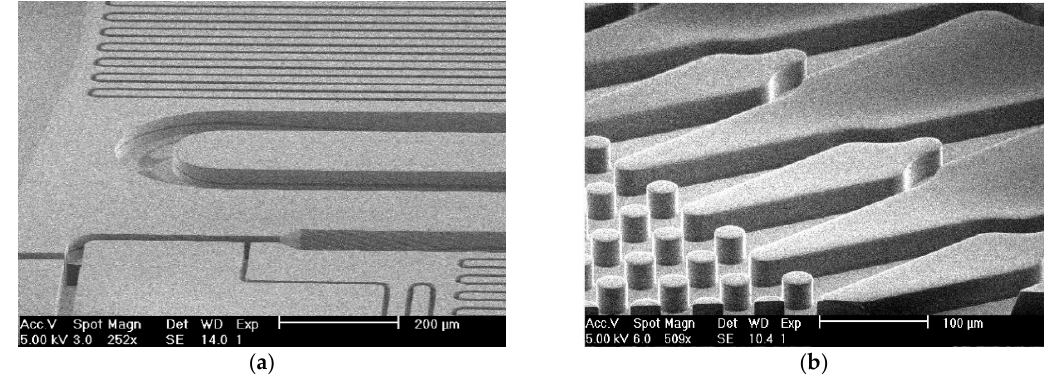
Figure 2. SEM images of the fabricated chips. ( a ) The silicon chip: Channels width varies from 10 um to 100 um; ( b ) The patterned polymer channels.